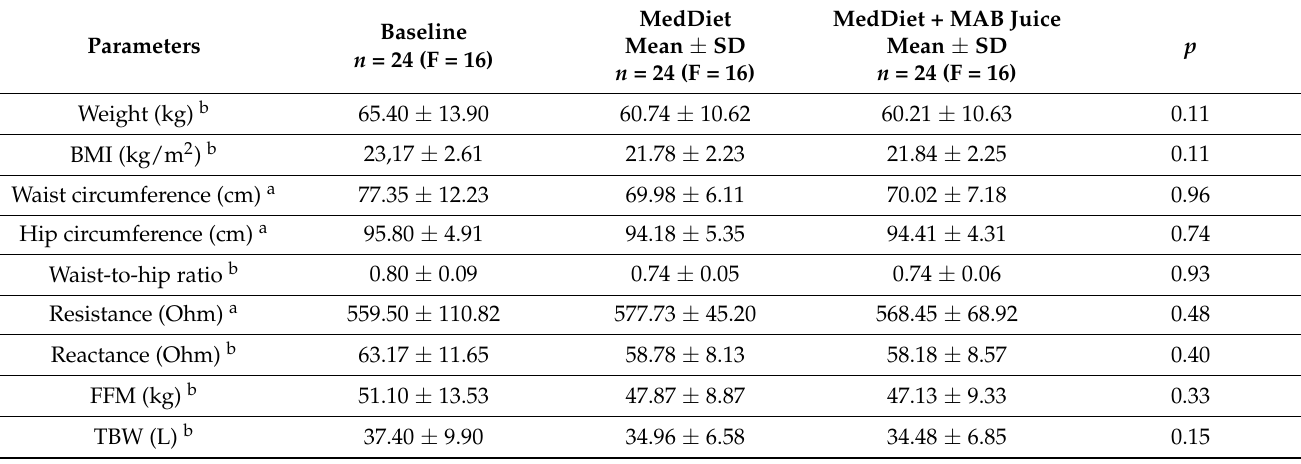
Table 3. Comparison of the nutritional status assessment values between MedDiet and Med-Diet + MAB juice